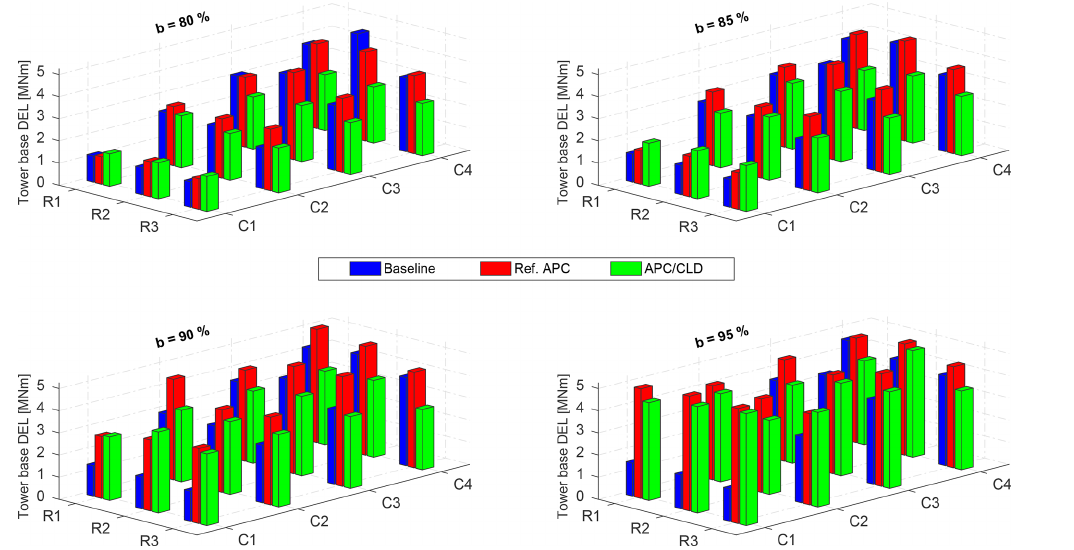
Figure 18. Corresponding DELs of the tower base fore–aft bending moment with the APC approaches for different levels of AGC power = 12 . 3MW, b = 80%, 85%, 90%, 95%, respectively, and c = 10%. R and C are referring to the demand (Eq. 23), parameterized as P base farm turbine positions inside the simulated wind farm (see Fig.